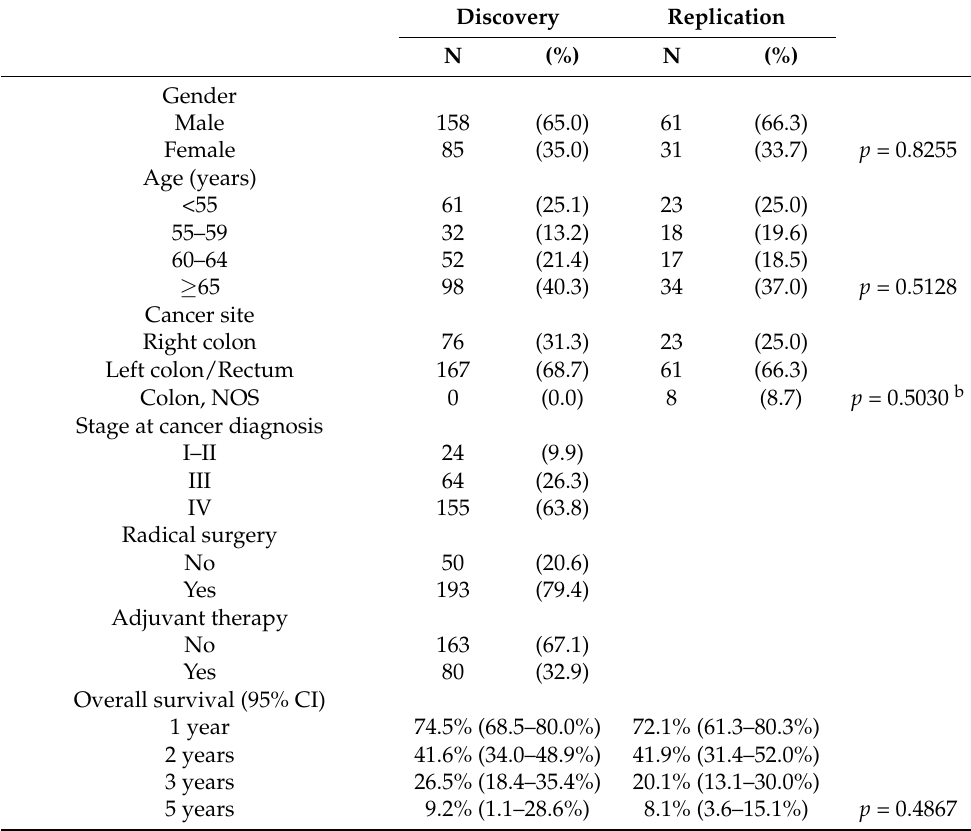
Table 1. Demographic and clinical characteristics of study populations (discovery cohort, n = 243 a ; replication cohort, n =